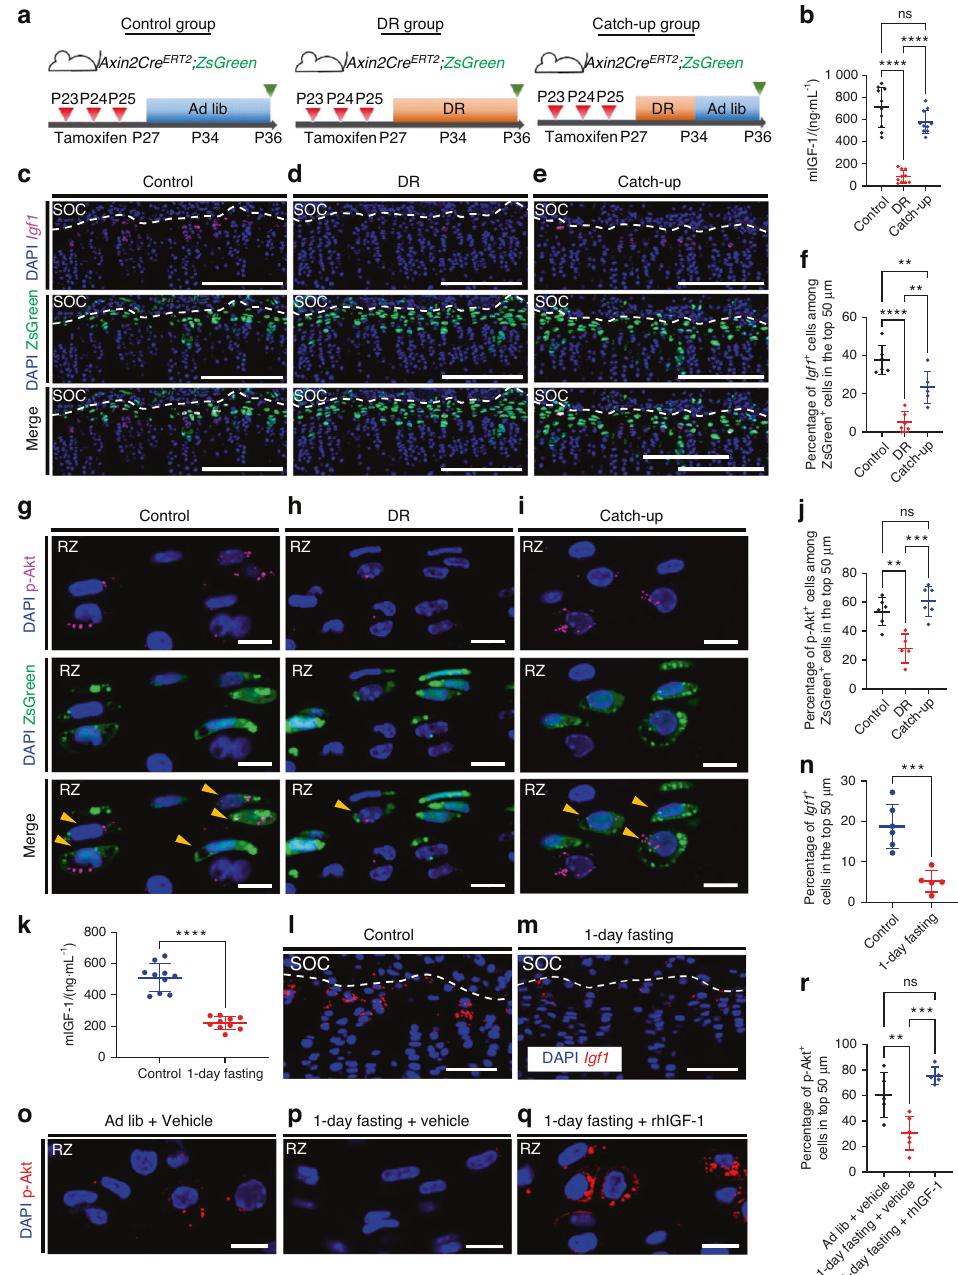
Fig. 6 IGF-1/PI3K signaling in resting chondrocytes changes in sync with nutritional availability. a Schematic diagrams of the fate- mapping analysis of Axin2 + cells in the proximal tibial growth plate in Axin2Cre ERT2 ;R26R ZsGreen mice (pulsed on P23 – 25 and traced for 13 days). b Measurements of circulating IGF-1 levels in the sera from the control ( n = 10), DR ( n = 10), and catch-up ( n = 10) groups. Adjusted **** P < 0.000 1 (control vs. DR), adjusted **** P < 0.000 1 (DR vs. catch-up), adjusted P = 0.063 1 (ns) (control vs. catch-up). c – e Representative images of in situ hybridization of Igf-1 and descendants of initially labeled Axin2 + cells (ZsGreen + cells ) in the proximal tibial growth plate in the control ( c ), DR ( d ), and catch-up ( e ) groups. f Percentage of Igf-1 + cells among ZsGreen + cells in the top 50 µm. Control group ( n = 6), DR group ( n = 6), catch-up group ( n = 6). g – i Representative images of immunoh i stochemistry for p-Akt and ZsGreen + cells in the resting zone of the proximal tibial growth plate in the control ( g ), DR ( h ), and catch-up ( i ) groups. j Percentage of p-Akt + cells among ZsGreen + cells in the top 50 µm. k – n Twenty-eight-day-old mice were fed ad libitum (control group) or subjected to one-day fasting (1-day fasting group). k Measurements of circulating IGF-1 levels in the sera of the control and one-day fasting groups. l , m Representative images for in situ hybridization of Igf-1 in the proximal tibial growth plate in the control group ( n = 6) ( l ) and the 1-day fasting group ( n = 5) ( m ). n Percentage of Igf-1 + cells in the top 50 μ m. *** P = 0.000 8. o – r Twenty-nine-day-old mice received vehicle (PBS) (vehicle group), vehicle followed by 1-day fasting (1-day fasting + vehicle group), or rhIGF-1 (1 μ g·g − 1 body weight) followed by 1-day fasting (1-day fasting + rhIGF-1 group). ( o ), 1-day fasting + vehicle group ( n = 6) ( p ) and 1-day fasting + rhIGF-1 group ( n = 5) ( q ). Percentage of p-Akt + cells in the top 50 μ m ( r ). Scale bars: 200 μ m ( c – e ), 50 μ m ( l , m ), 10 µm ( g – i , o – q ). All data are presented as the mean ± SD. Statistical signi fi cance was determined by one-way analysis of variance and Tukey ’ s multiple comparison test ( b , f , j , r ) or by unpaired two-tailed t test ( k , n